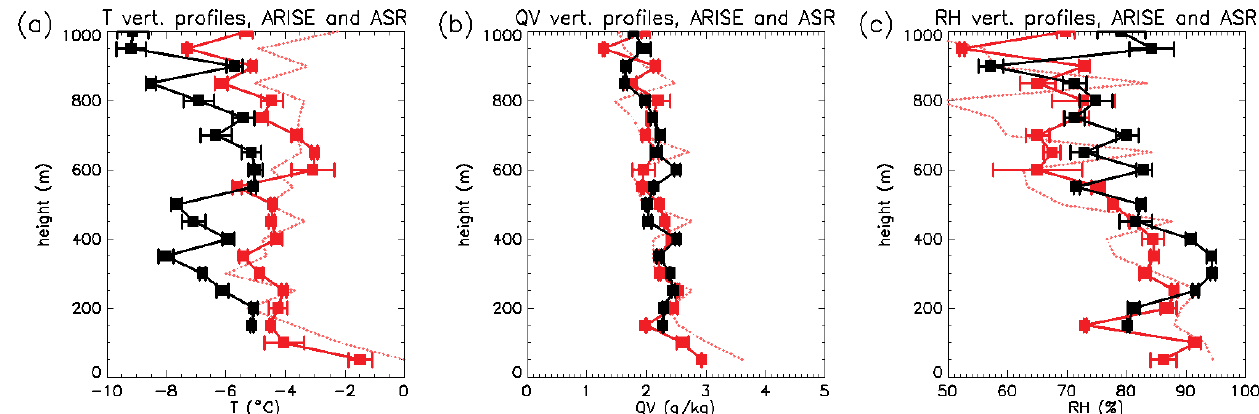
Figure 5. Vertical profiles of (a) temperature ( T ), (b) specific humidity (QV), and (c) relative humidity (RH) for ARISE (black) and ASR (red) along the ARISE flight tracks. The whiskers represent the 95% confidence interval using a two-tailed t test. In addition, the vertical profiles from ASR for the full Beaufort Sea domain are shown with the dashed red